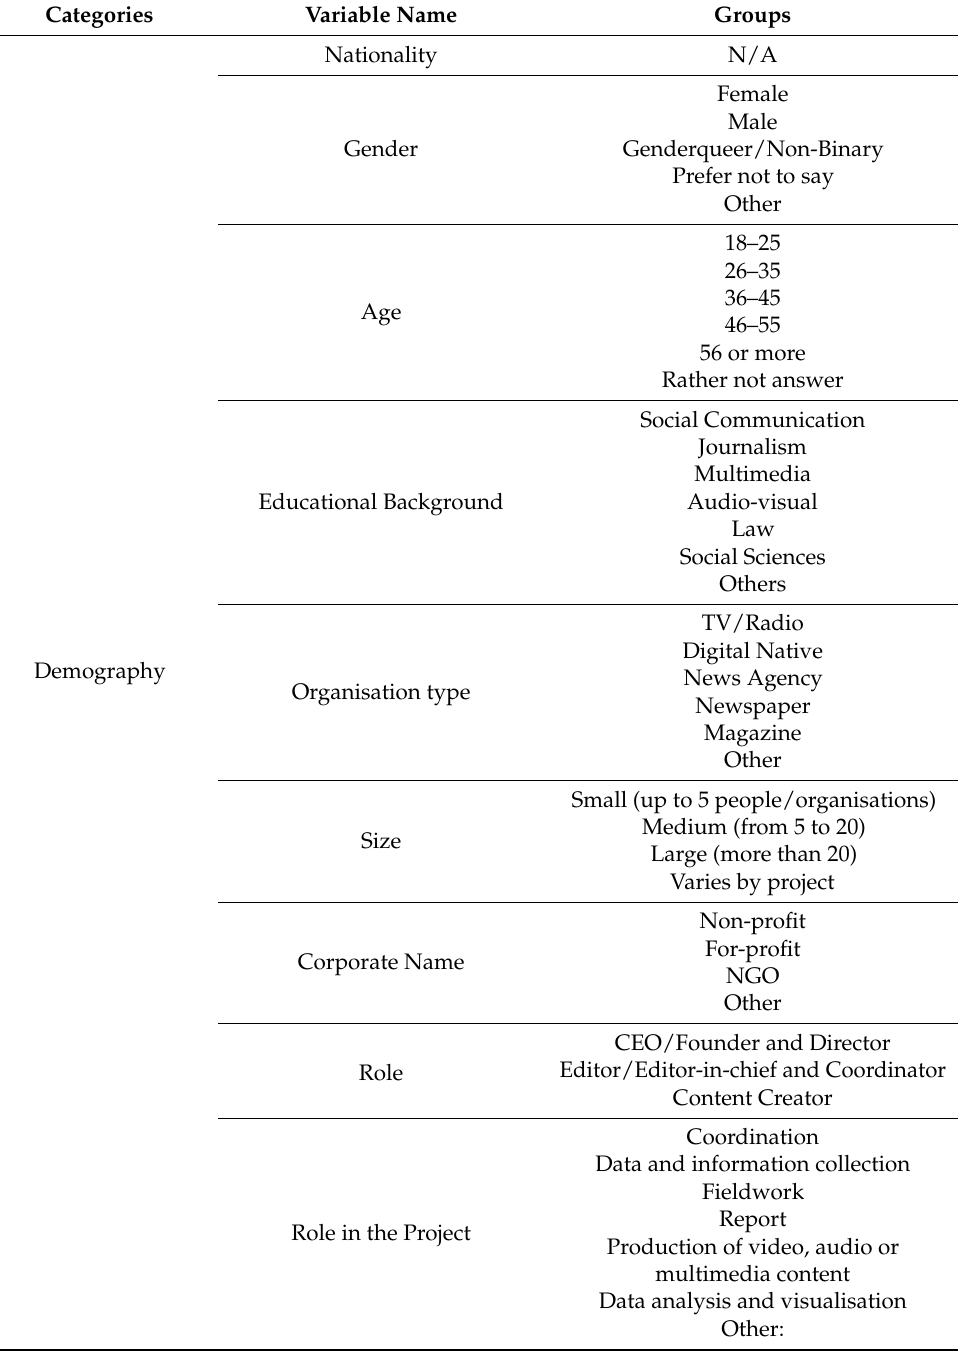
Table 5. Categories, Variables and